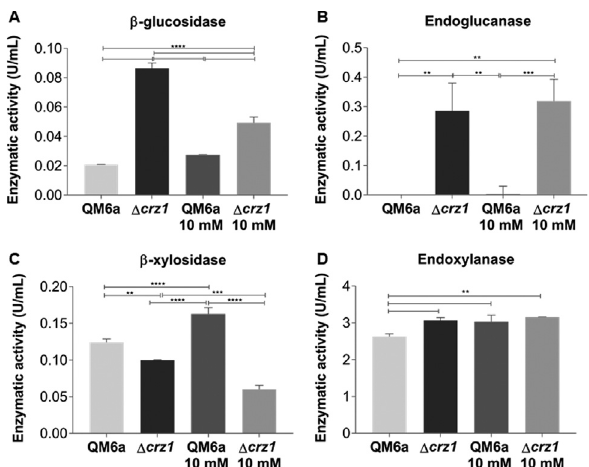
Figure 7 - Enzymatic activity of (cid:6) -glucosidase (A), endoglucanase (B), (cid:6) -xylosidase (C) and endoxylanase (D) from QM6a and (cid:2) crz1 T. reesei strains supernatants after 8 h of growing in SCB and SCB supplemented with 10 mM Ca 2+ . Results are represented as absolute values in units per milliliter and are representative of a mean of three biological replicates with standard deviation. Statistical significance is represented as asterisks, considering p-value as <0.05 (*), <0.01 (**), <0.001 (***) and p<0.0001